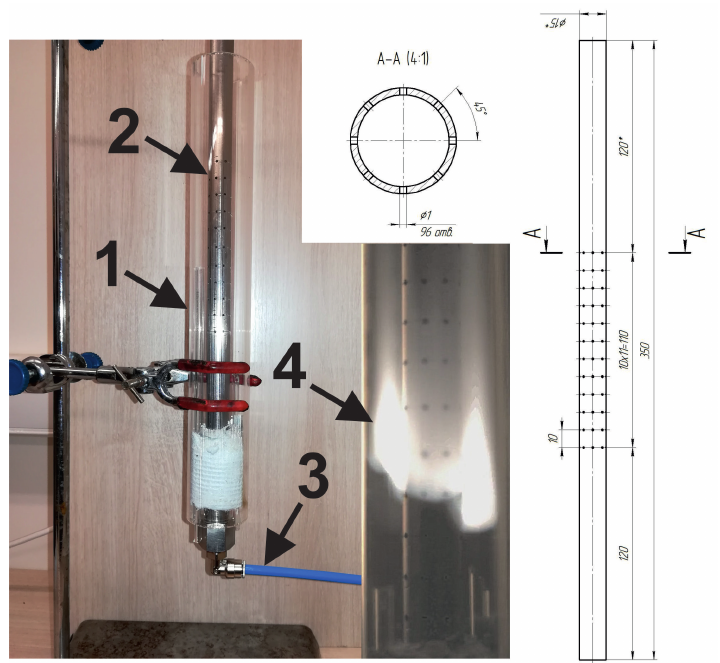
Figure 1. Photography of the coaxial burner (1—outer channel made of glass, 2—inner steel channel with perforated wall, 3—feeding system), instant photo of the flame front (4) and scheme of the inner